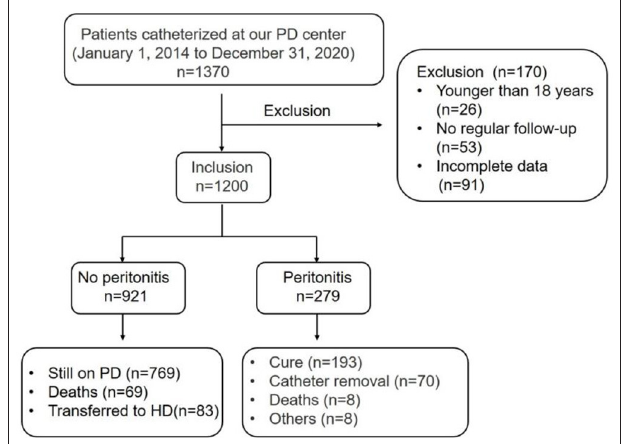
FIGURE 1 | Flow chart for the study participants enrollment and